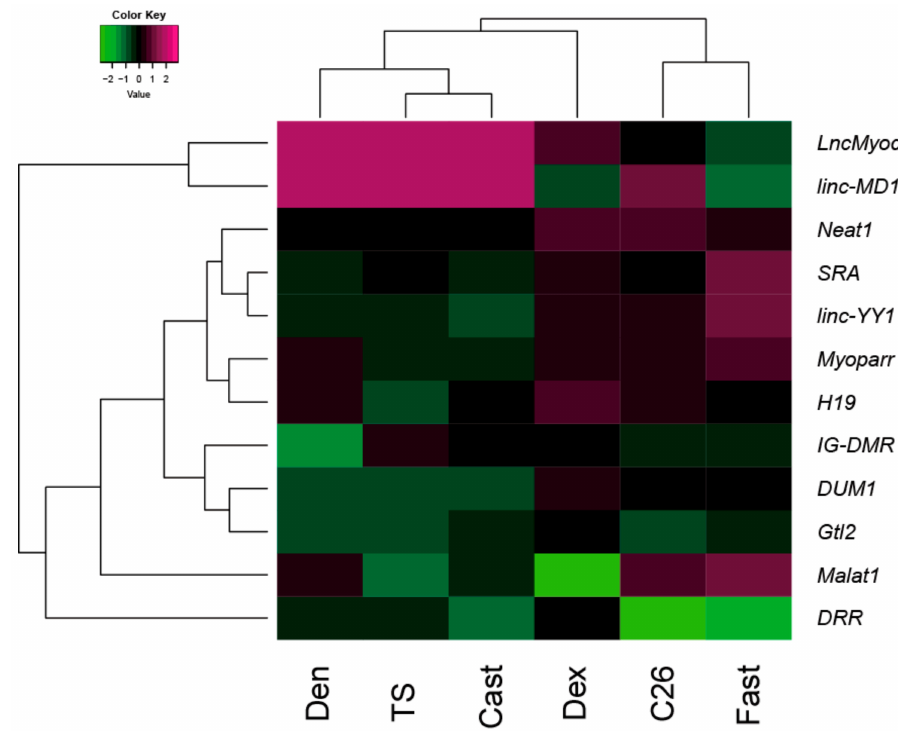
Figure 3. Cluster analysis of the expression profiling of lncRNAs in muscle atrophy conditions. The result of the cluster analysis of the expression profile of lncRNAs in muscle atrophy is shown as a heatmap (values are z-scores). Den; denervation treatment. TS; tail suspension treatment. Cast; casting treatment. Dex; dexamethasone administration. C26; cancer cachexia. Fast; fasting